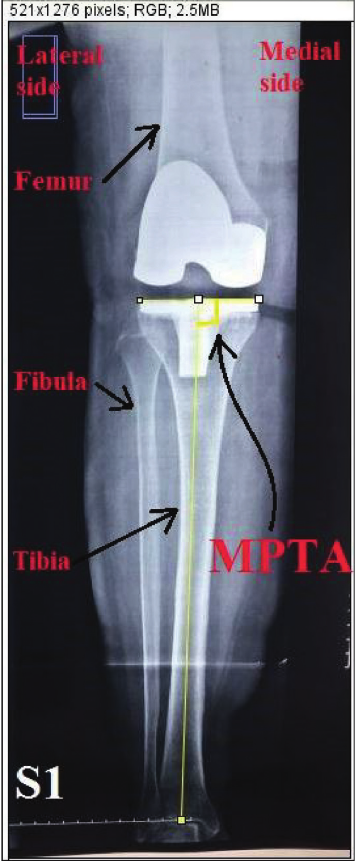
Figure 11: MPTA measurement using ImageJ